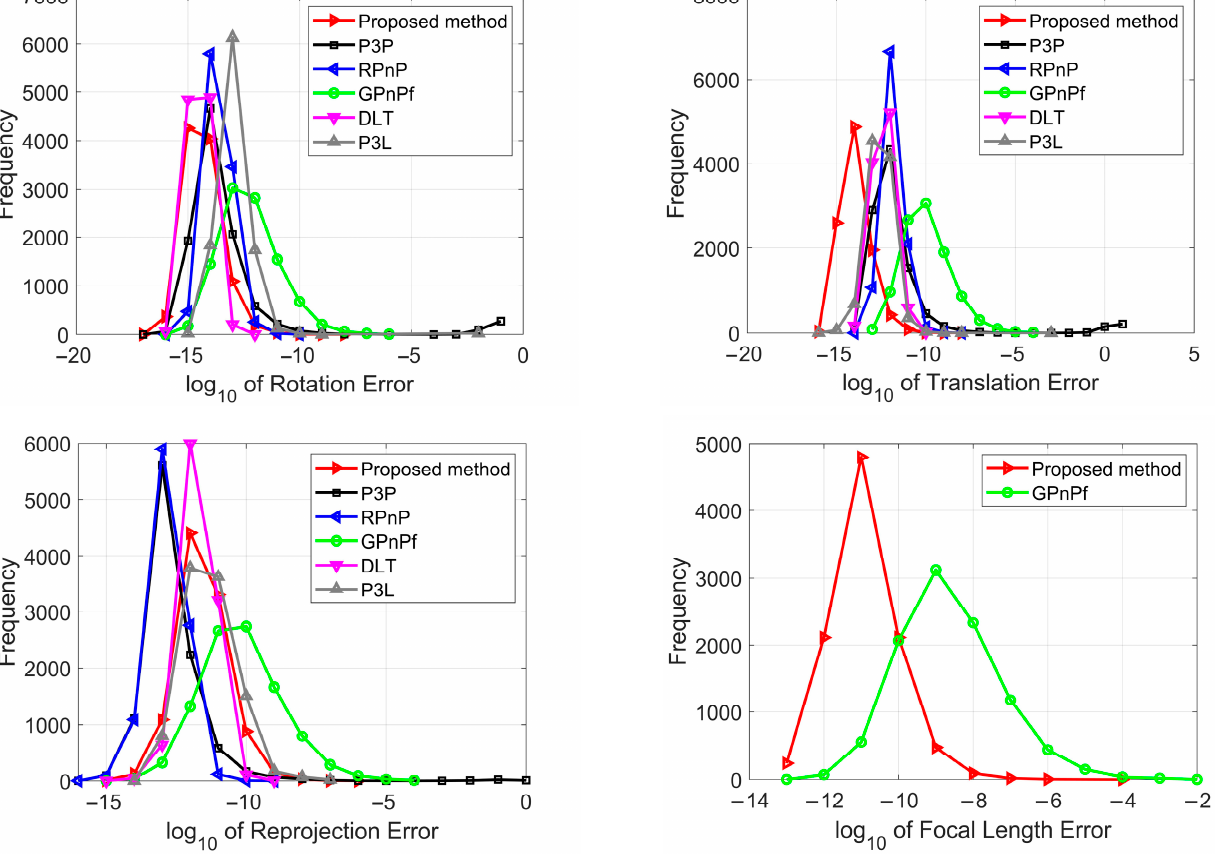
Figure 7. Numerical stability for our proposed method (red), P3P (black), RPnP (blue), GPnPf (green), DLT (purple) and P3L (gray). The top left is the rotation error, the top right is the translation error, the bo tt om left is the reprojection error, and the bo tt om right is the focal length error.